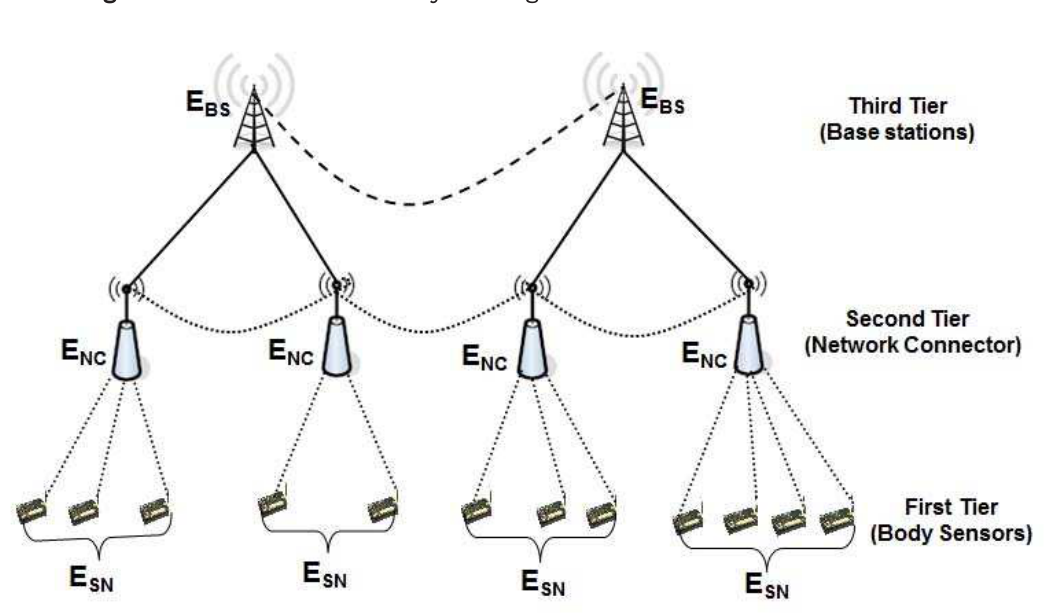
Figure 5. The hierarchical key sharing architecture of the whole